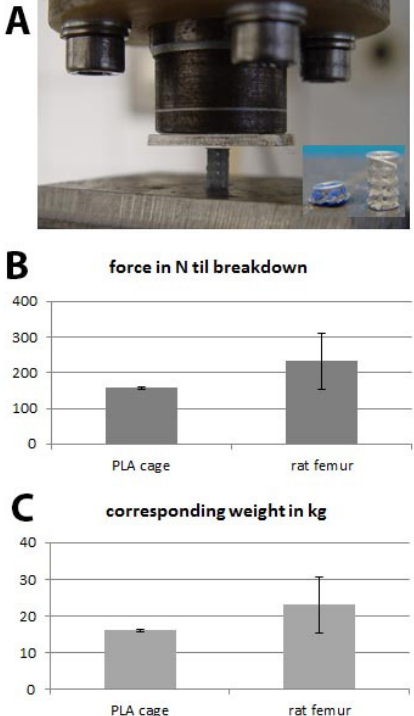
Figure 1. Biomechanical testing; ( A ) experimental setting; ( B ) applied force until breakdown of the polylactide acid (PLA) cage and rat femur and the ( C ) corresponding weight in kg.